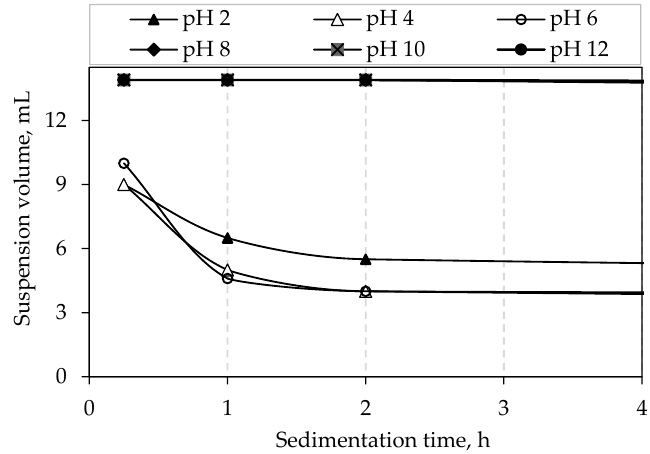
Figure 6. Sedimentation rate of water-based alumina suspensions with optimal composition in the first hours after preparation.